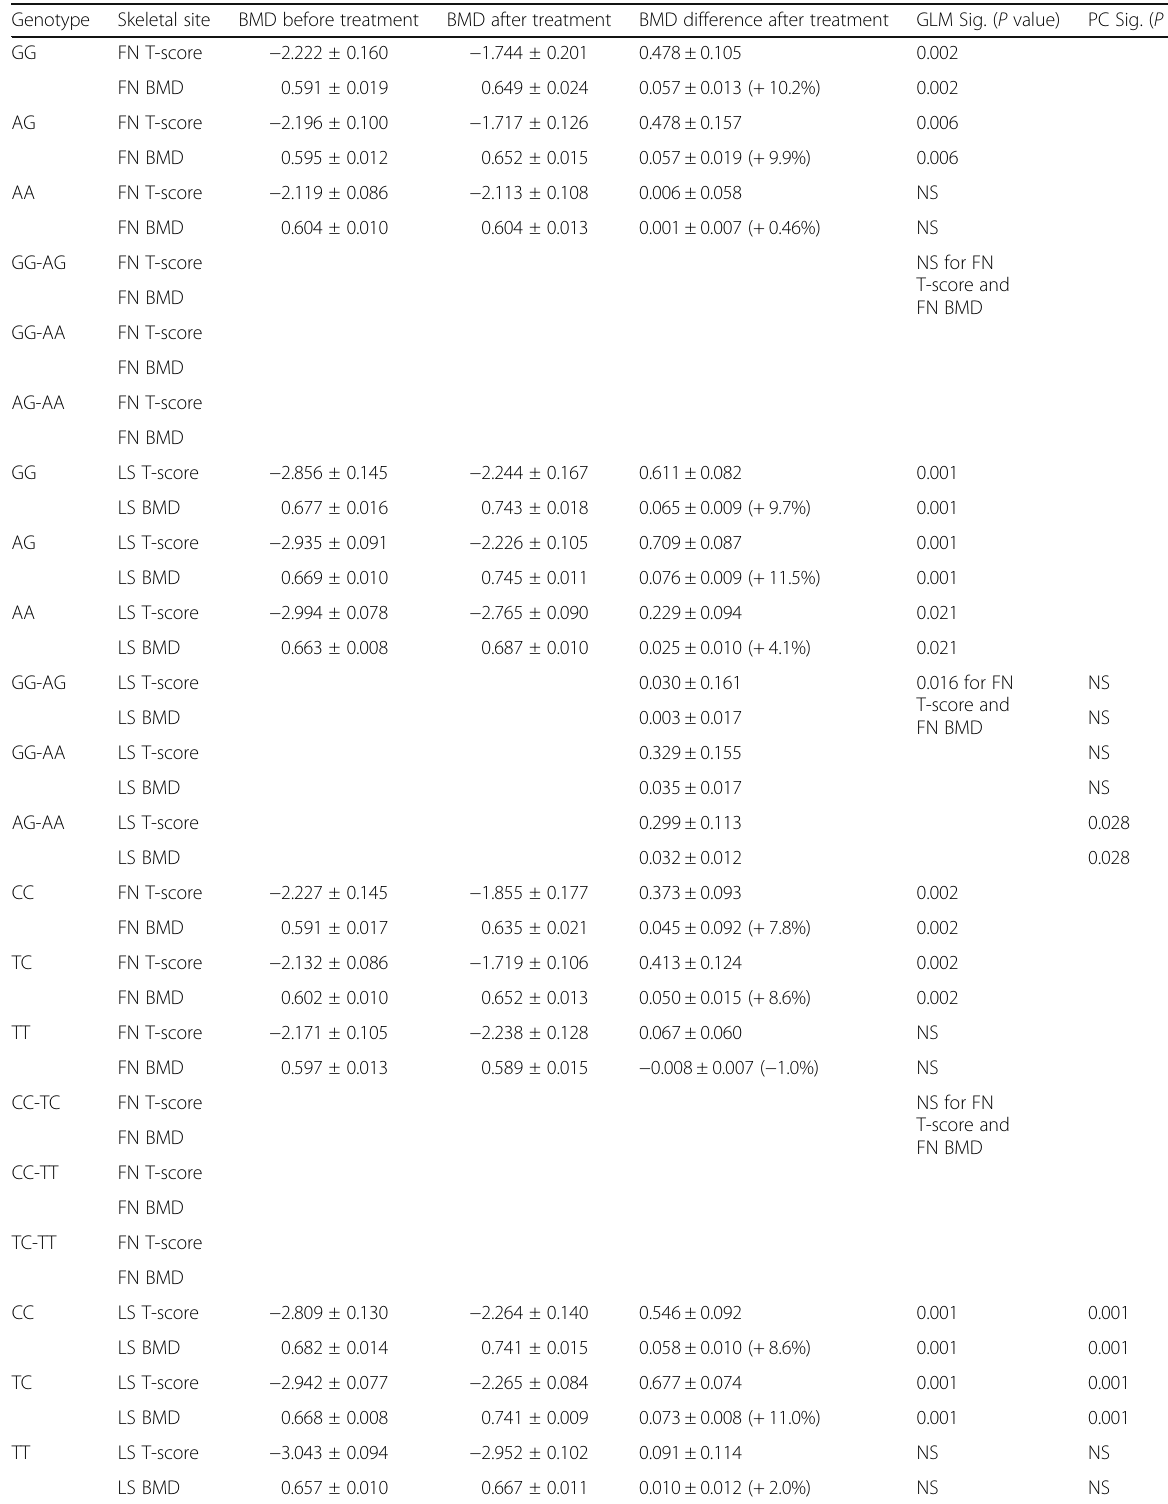
Table 7 BMD changes after raloxifene therapy in relation to the rs9340799 and rs2234693 genotypes